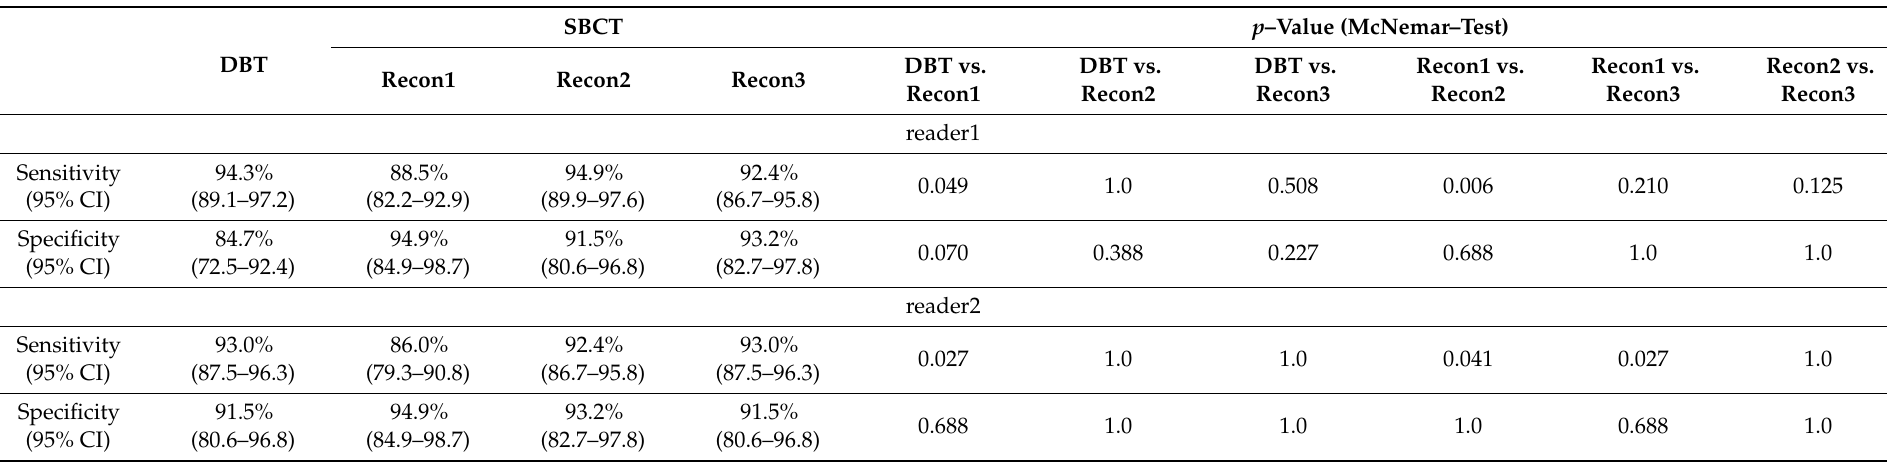
Table 1. Sensitivities and specificities for the detection of microcalcifications in 216 segments (prevalence